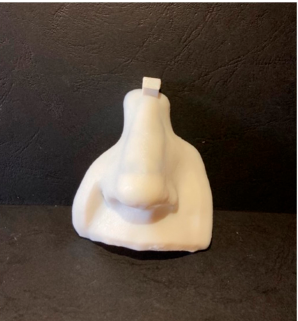
Figure 7. 3D-printed prototype of the nasal prosthesis manufactured using 3D printing Polyjet technology, including both the prosthesis volume in the rubber-like material and the connecting substructure in rigid polymer.